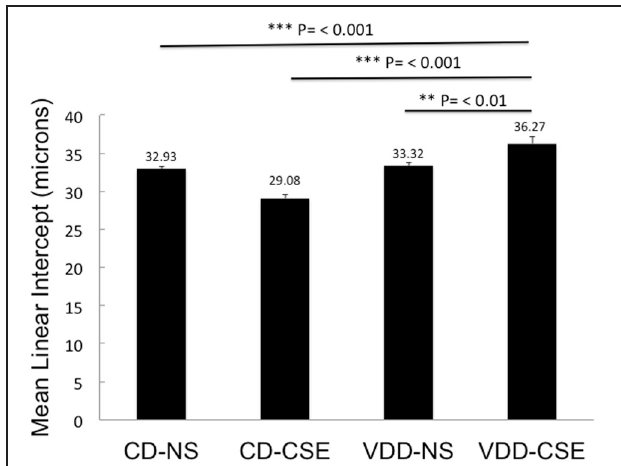
FIGURE 4 | Total lung capacity (TLC) in experimental groups. Over the course of three separate experiments, total lung capacity was determined by flexi Vent™ in 63 mice. Each point represents the data from one mouse with 14 to 17 mice per treatment group. Horizontal bars mark medians. A Two-Way ANOVA indicated that the mean TLC in the VDD-NS group and the CD-CSE group was significantly greater than the mean TLC in the control group (CD-NS) (indicated by ∗∗∗ in the figure; p = 0 .